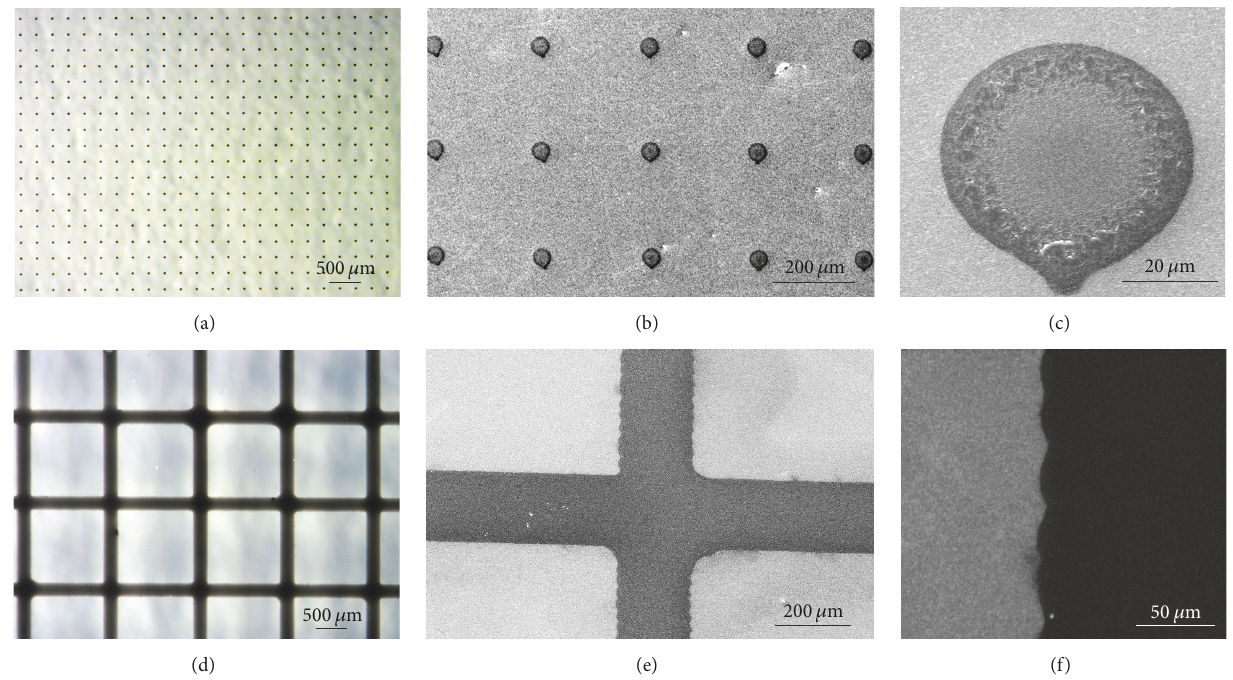
Figure 4: Optical and SEM micrographs of inkjet-printed NiCo 2 O 4 . In (a)–(c), a dot array pattern is presented, and, in (d)–(f), a multiline pattern is depicted.